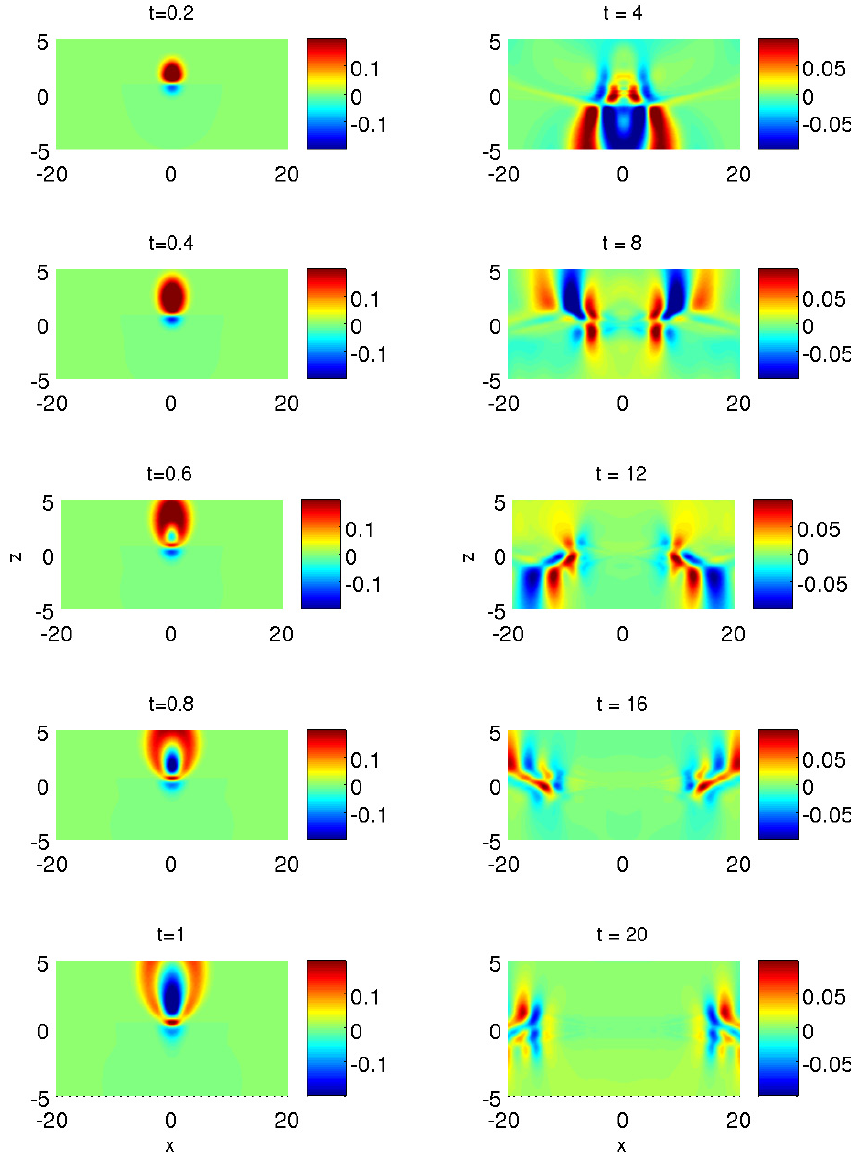
Fig. 3. Normal velocity v z (x,z,t) in the x-z-plane for different values of time showed above each graph. The left column describes the first instants following the pressure burst: a fast wave is clearly expanding in the northern lobe. The right column shows the further evolution of the propagation for longer times: the eigenmode structure localized within the current sheet propagates along the x-axis. In the second part of the propagation, the development of the MHD eigenmodes can be observed from t = 4 to t =